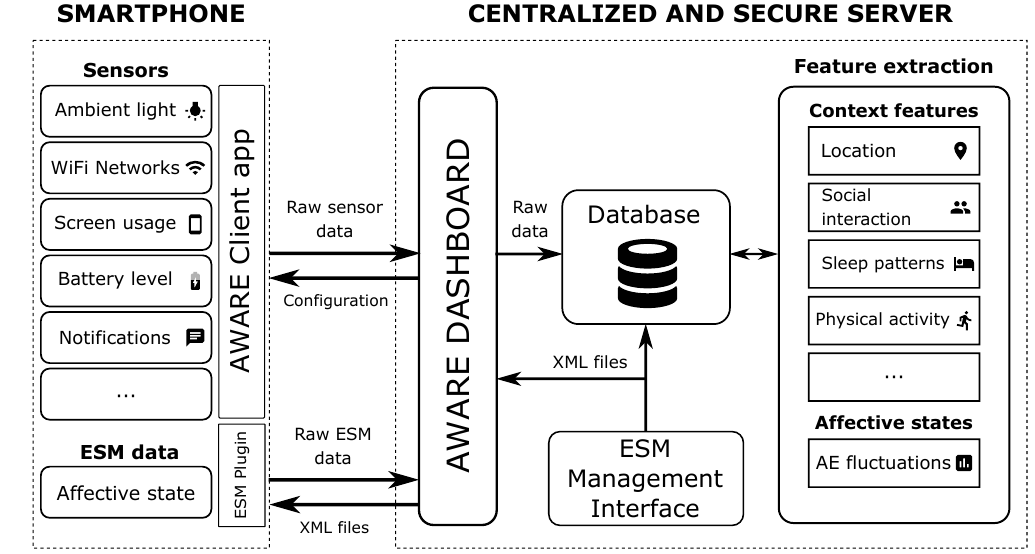
Figure 2. Architecture of the monitoring